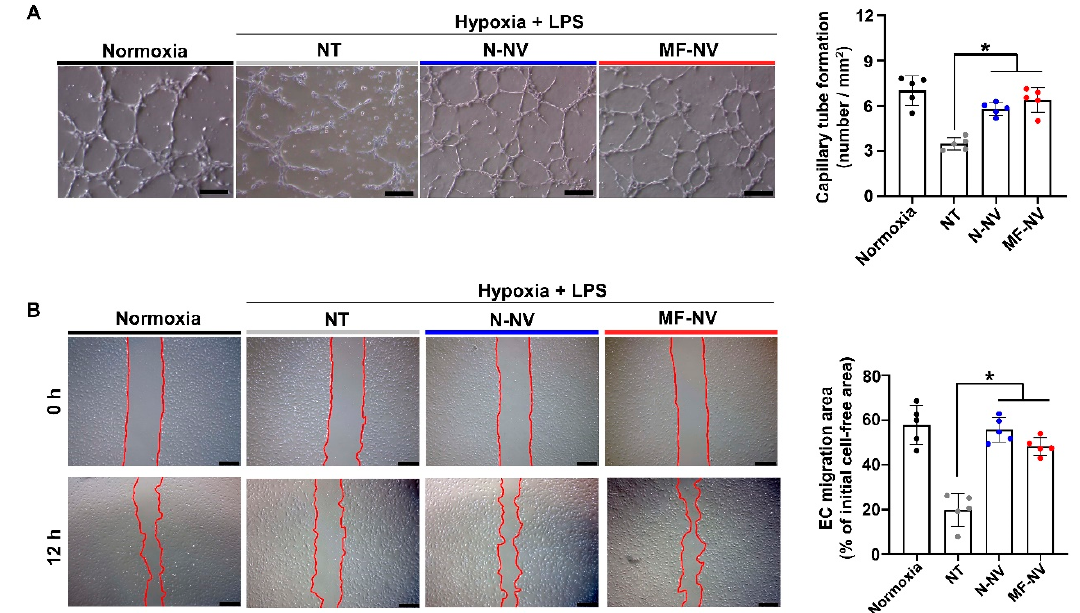
Figure 4. In vitro anti-inflammatory effects of NVs. Macrophage polarization after treatment. Relative mRNA expression levels in M1 M Φ of the markers of inflammatory M1 macrophages ( Il1b , Il6 , and Nos2 ) and reparative M2 macrophages ( Arg1 , Cd206 , and Il10 ), as evaluated by qRT-PCR (n = 4 per group). All data were normalized to those of M0 M Φ . NT indicates no treatment. * p < 0.05 by using one-way ANOVA followed by post-hoc Bonferroni test. All values are mean ± SD.